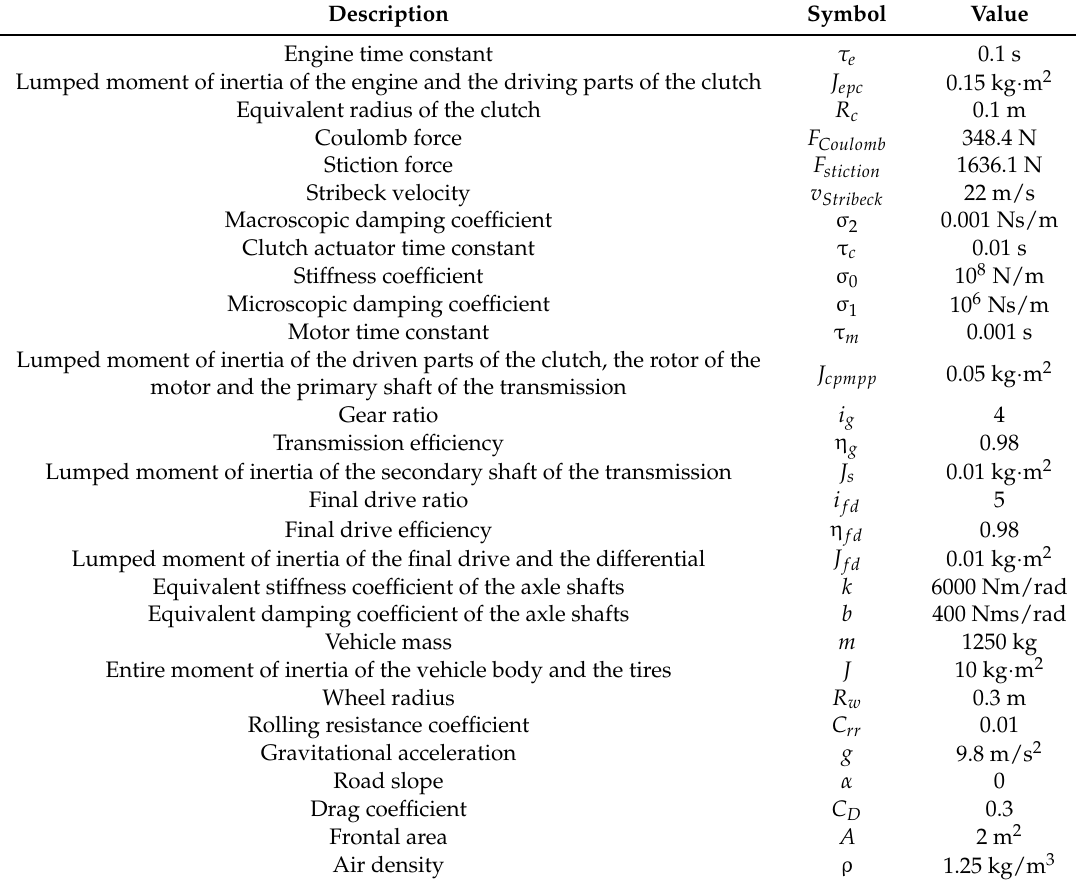
Table 1. Parameters of the simulation-oriented